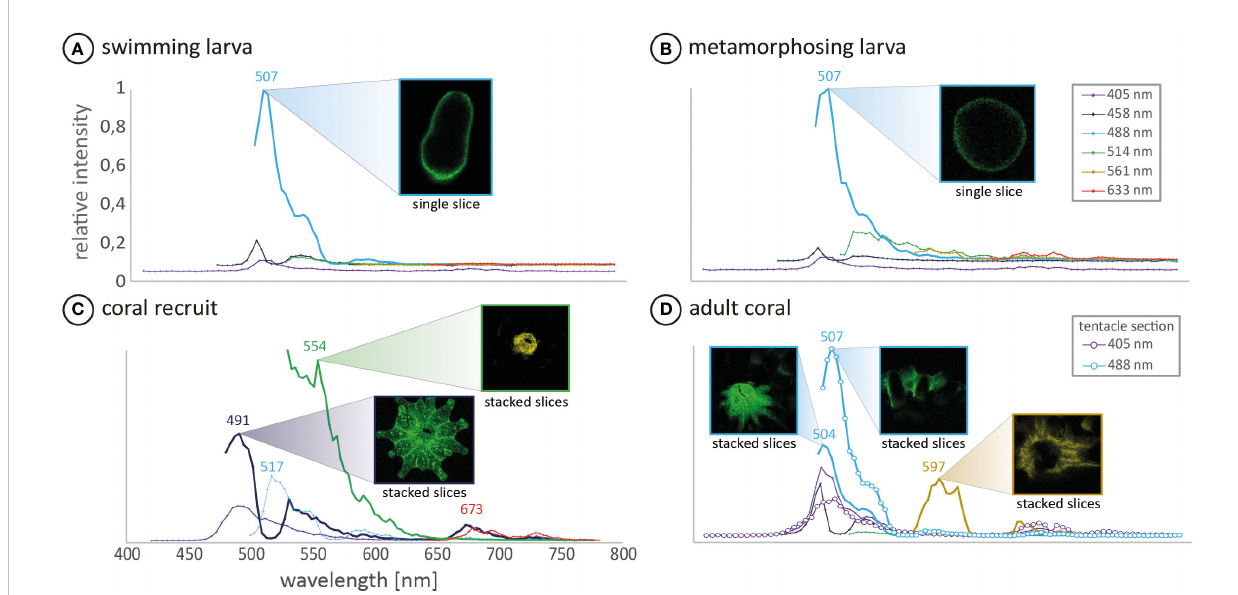
FIGURE 3 In vivo fl uorescence spectra of (A) a Leptastrea purpurea coral larva and (B) a 48h-old metamorphosed coral larva (C) coral recruit (D) focuses